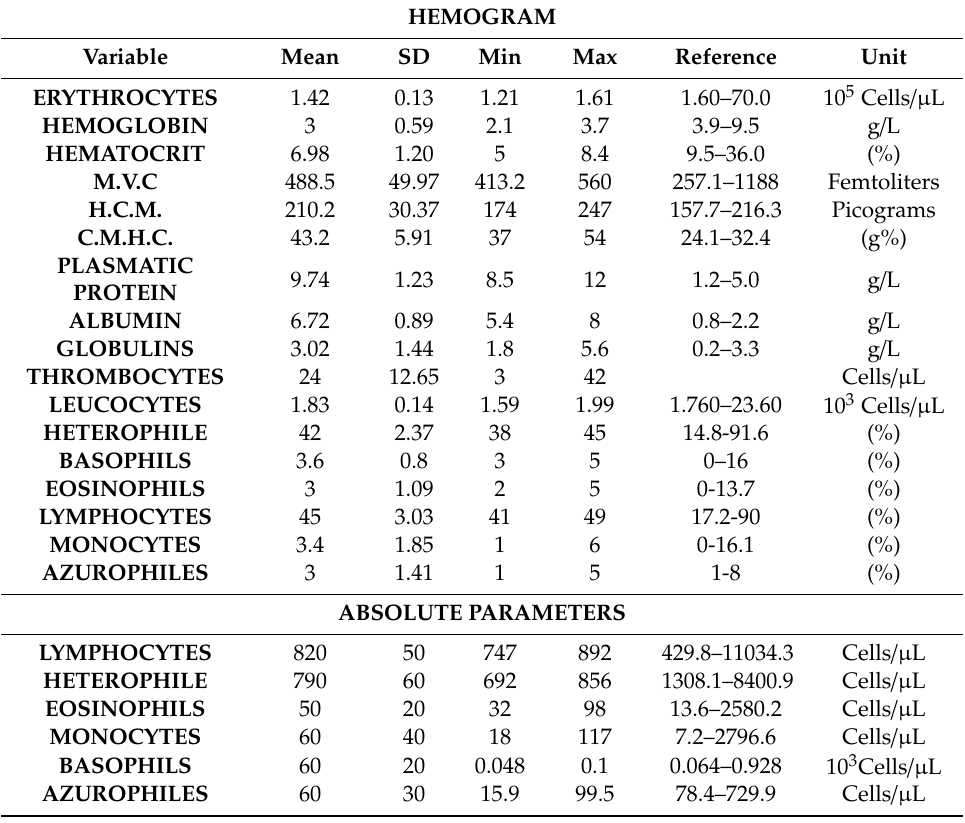
Table 2. Blood parameters of captive loggerhead sea turtles from El Rodadero Aquarium, Santa Marta. SD = standard deviation (n = 5). Reference values taken from Yang et al., and Rouselet et al.